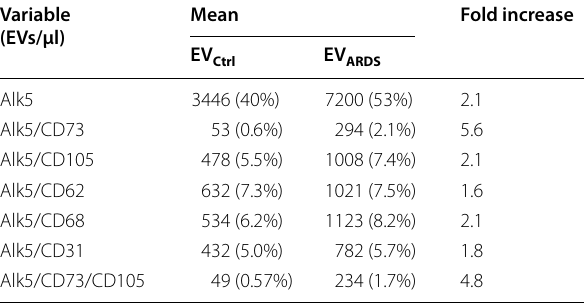
has mesenchymal stem ARDS